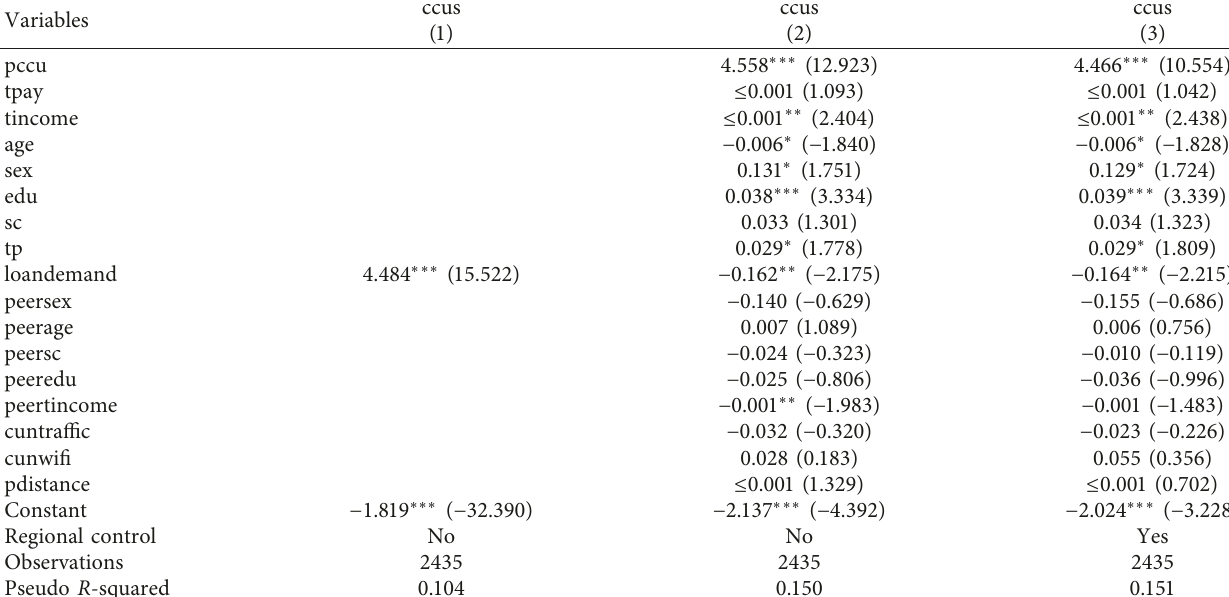
Table 3: Estimation results of the peer